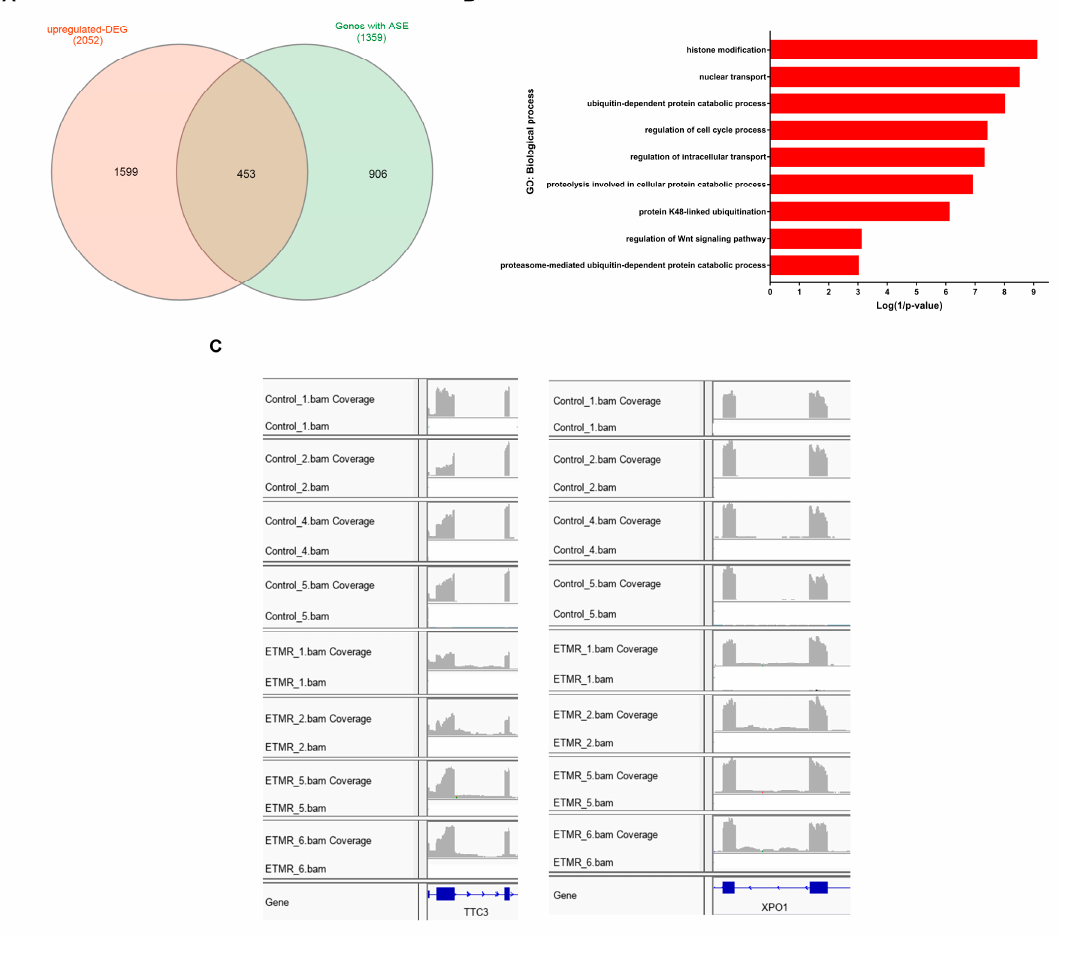
Figure 5. Enrichment analysis and examples of up-regulated differentially expressed genes (DEGs) with significant AS events. ( A ). Venn diagram showing common genes between DEGs and genes with significant AS events. ( B ). Biological processes are enriched by the up-regulated DEGs with significant AS events. ( C ). IGV(Integrated Genomic Viewer) plots demonstrate RIs in E3 ubiquitin-protein ligase ( TTC3 ) and exportin-1 ( XPO1 ) in ETMR compared to fetal control samples.